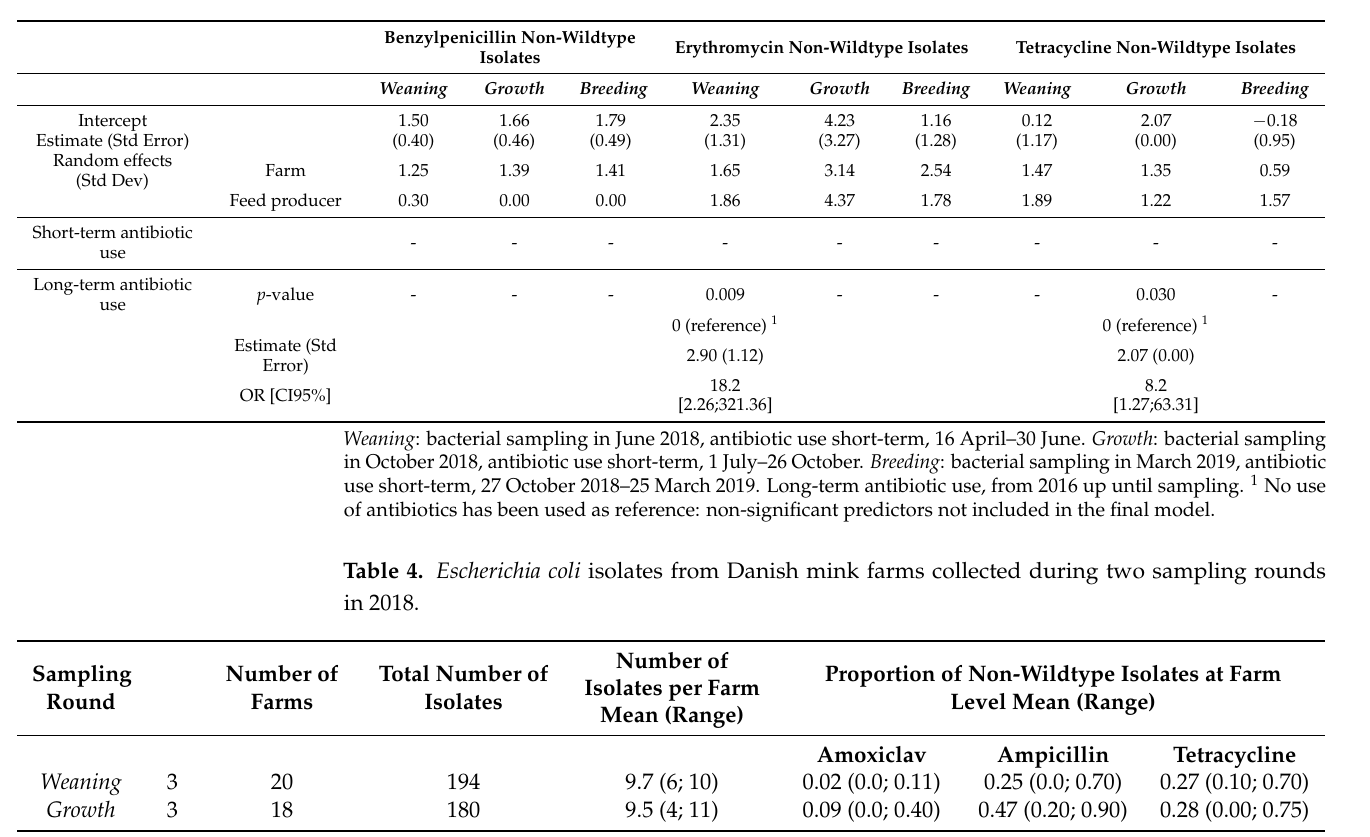
Table 3. Final multivariable, generalized linear mixed models with binomial outcomes of wildtype/non-wildtype of Staphylococcus delphini isolates, against one of three antibiotics (penicillins, macrolides, tetracyclines).